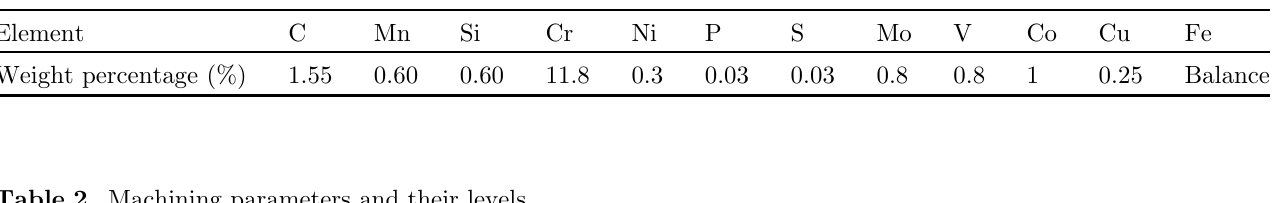
Table 1. Chemical composition of D